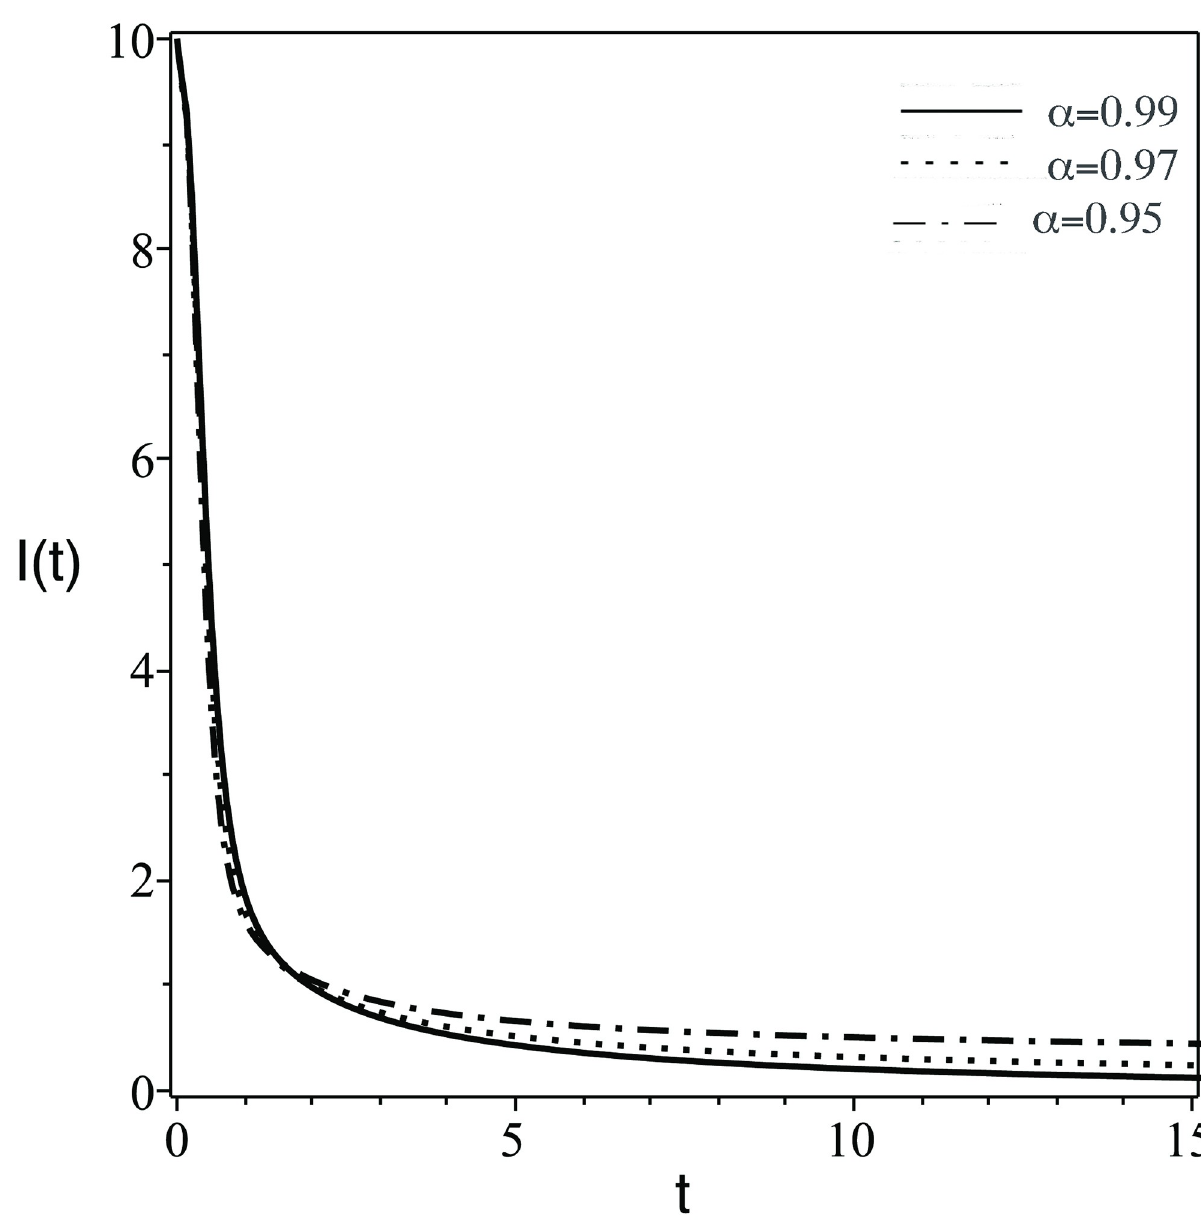
Fig 3. Same as Fig 1 but for the number of concentration of infected CD4 + T-cells, I ( t ).